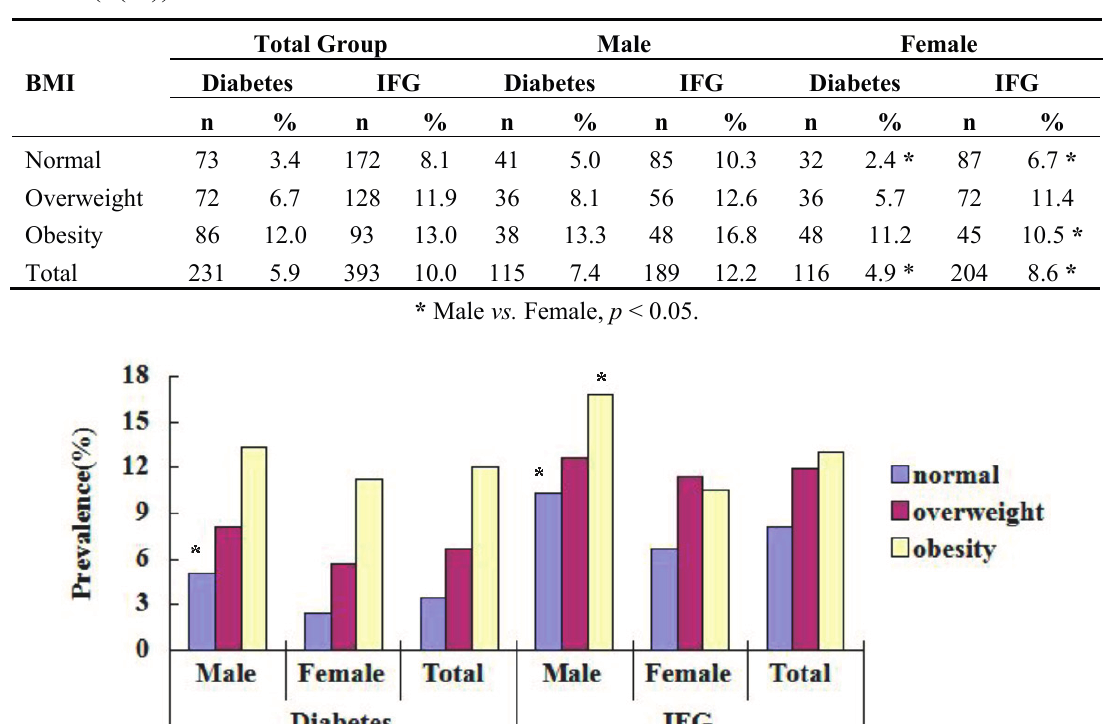
Table 3. Prevalence of diabetes and impaired fasting glucose (IFG) in different BMI for Kazak (n(%)).